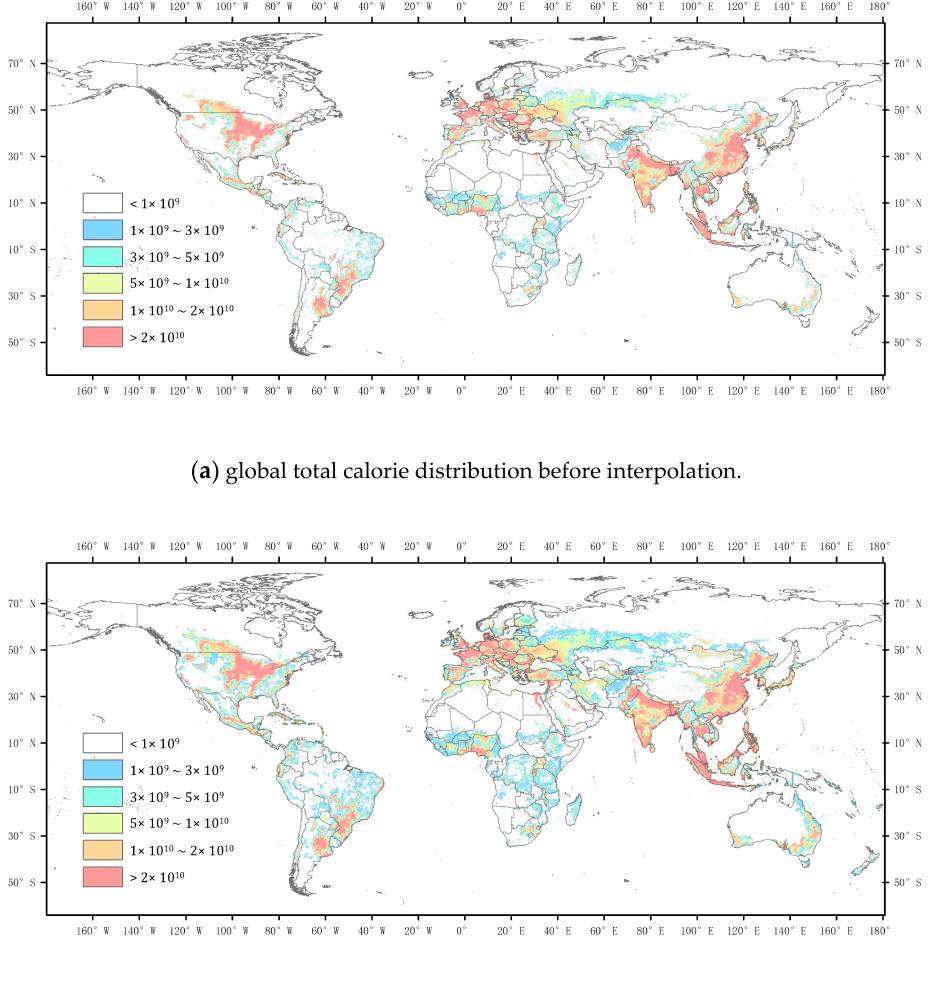
Figure 4. The comparison of global total calorie distribution before and after interpolation. According to Supplementary Table S1, the sum of global total calorie under SSP4-RCP6.0 in 2030 is the largest and differs most from the sum of origin total calorie. Thus, we map interpolated calorie distribution under SSP4-RCP6.0 in 2030 to visualize the difference. Antarctica and Greenland are not included on the map.